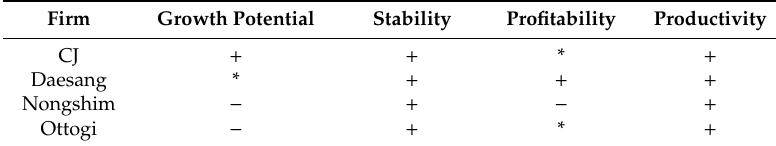
Table 5. Summary of financial sustainability for each firm (years: 2008~2018).